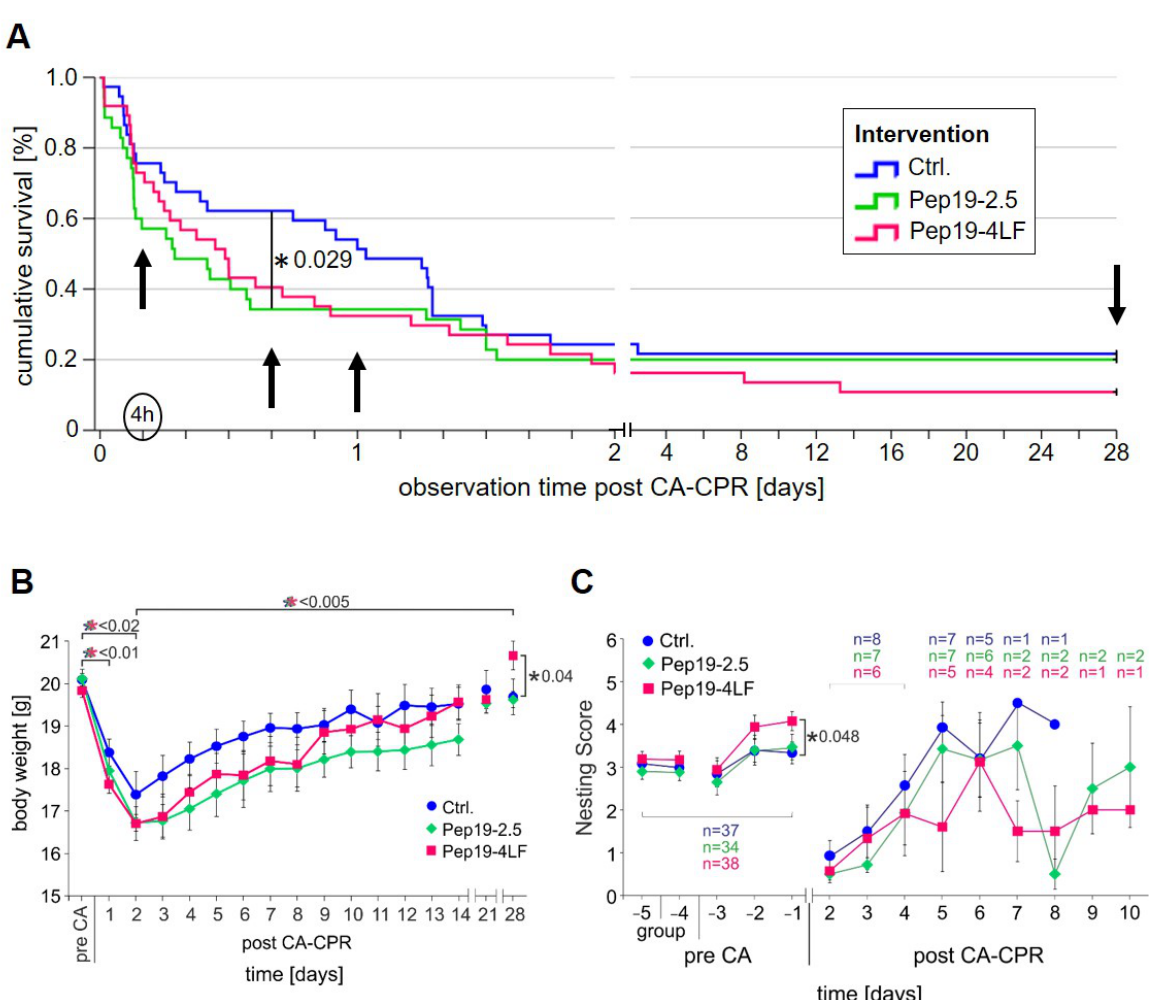
Figure 2. Survival and recovery parameters after CA-CPR. ( A ) Kaplan-Meier plot for mouse survival after successful resuscitation following 8 min of cardiac arrest (CA) within the 28-day observation period. No significant differences between the different groups (controls=Ctrl. (blue): n = 37; Pep19-2.5-treated (green): n = 34; and Pep19-4LF-treated (berry): n = 37) were detected in survival at the end of observation ( p = 0.465). At 16 h of observation, the difference between the groups was greatest and between control and Pep19-2.5-treated with p = 0.029 significant. ( B ) Course of body weight in the observation period of 28 days of all groups was presented as mean ± SEM. Tendentially, the body weight of the control mice does not decrease as much as in the treated groups on Day 2 post- CA-CPR. Thereafter, the animals of all groups gain weight continuously. There was no significant difference between the groups over the time period. Only on Day 28 did the Pep19-4LF treated animals (n = 5) show a higher body weight compared to the control animals (n = 8; p = 0.040). ( C ) The nesting behavior (mean ± SEM; n number of animals) was not significantly different between the investigated groups on different days as well as the time (days) to reach the initial nesting score after CA-CPR. The difference between control and Pep19-4LF groups was just not significant on Day 5 ( p = 0.056). On Days 7 and 8, statistical comparison between groups was not performed because only 1 control animal and 2 animals per peptide treatment group were left in the experiment. For the animals that had reached the nesting score before resuscitation, the experiment ended and so did the single animal housing. Schemes follow the same